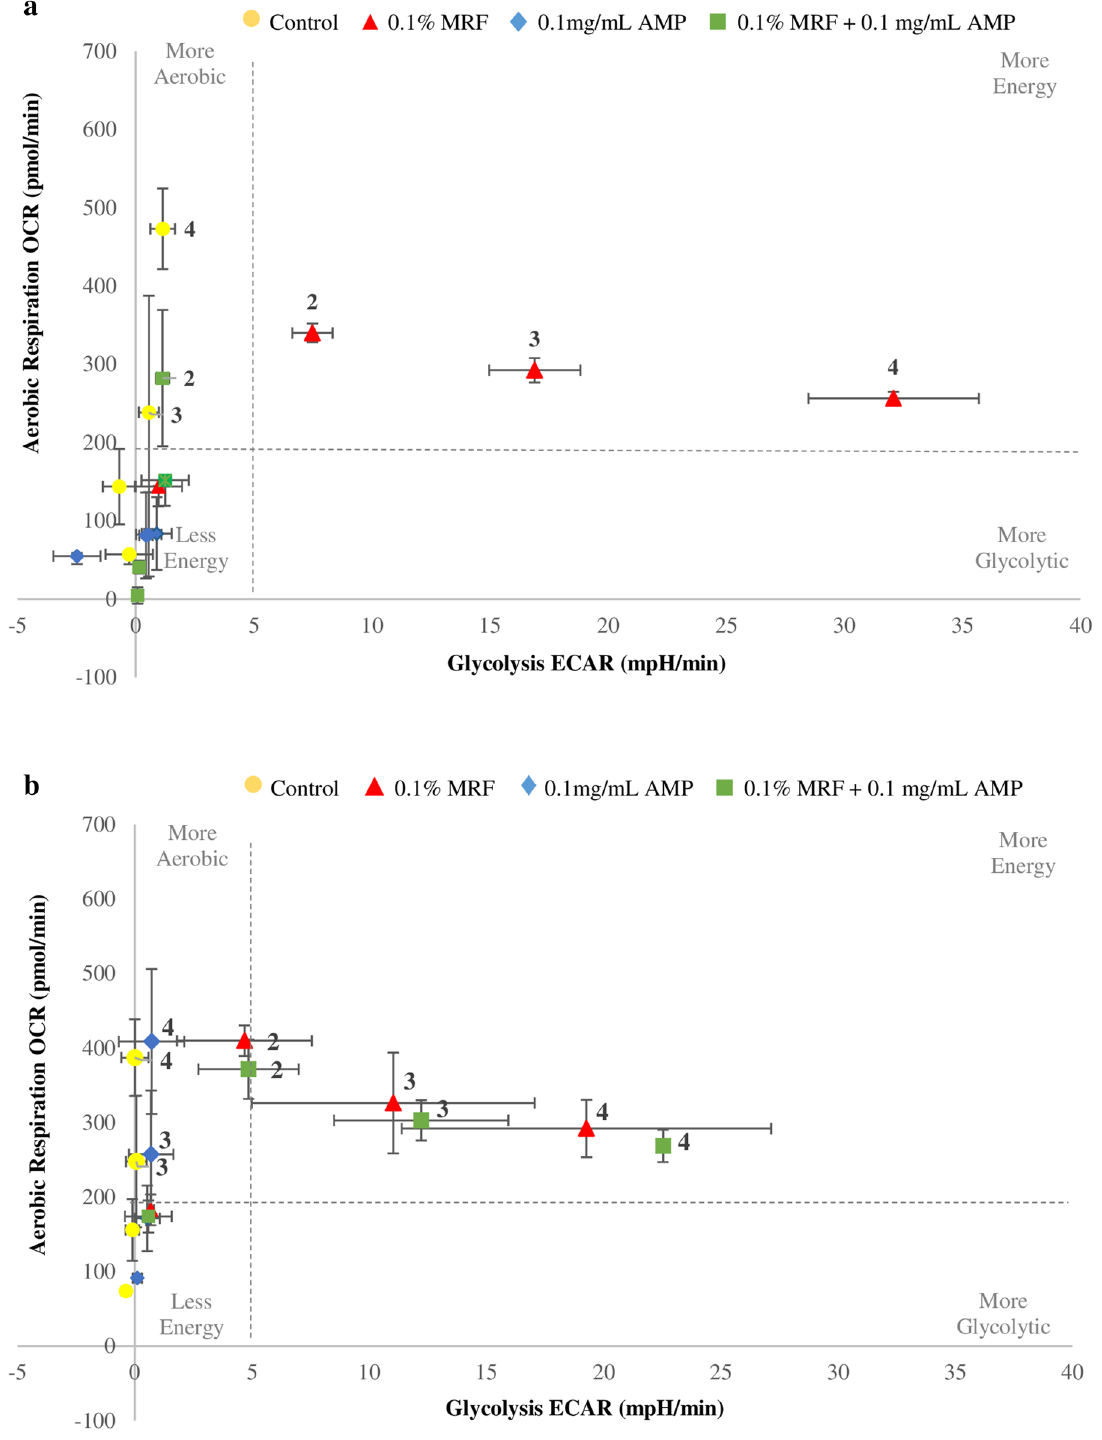
Figure 5. Bioenergetic real time changes in OCR/ECAR ratio of (a) antibiotic susceptible E. coli and (b) antibiotic resistant E. coli . Numbered data points represent the following time-points; (1) 15.00 ± 0.80 (basal*), (2) 100.00 ± 4.56, (3) 150.00 ± 0.26, (4) 200.00 ± 1.41 min, respectively. Only data points outside the basal region (bottom left) are labelled with representative time-points to enhance visibility of illustrated data. Each value was expressed using mean of triplicates for each biological replicate (n = 3), standard deviation is represented by error bars. Control refers to no MRF supplementation/AMP treatment; *Basal OCR measured prior to automated antibiotic/M9